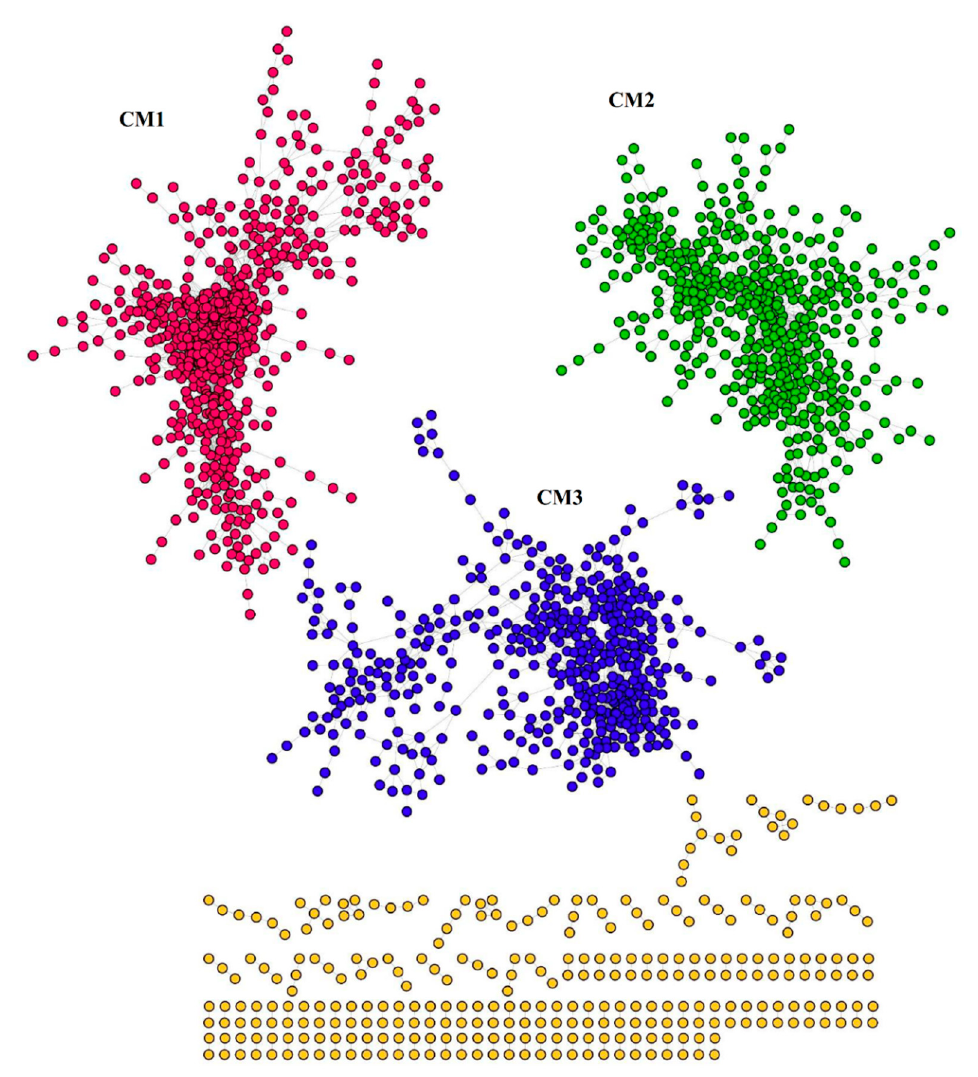
Figure 6. The co-expression network of the 4276 common DEGs in the three different time point comparison groups during the early phases of AR formation in mulberry stem hardwood cuttings. Three major co-expression modules (CMs, subnetwork with more than 30 genes) were identified, and the clustered dots with different colors represent genes belonging to a specific CM, the scattered yellow dots indicate non-co-expressed genes.